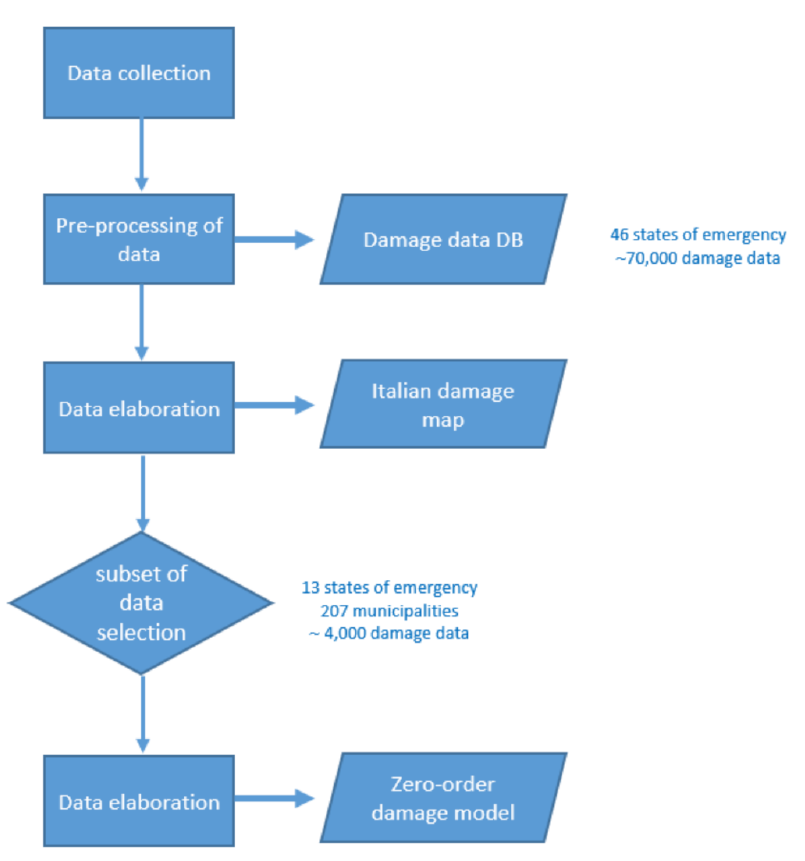
Figure 1. The workflow diagram identifies the main elaboration steps (rectangles), implemented data, and outputs of the research